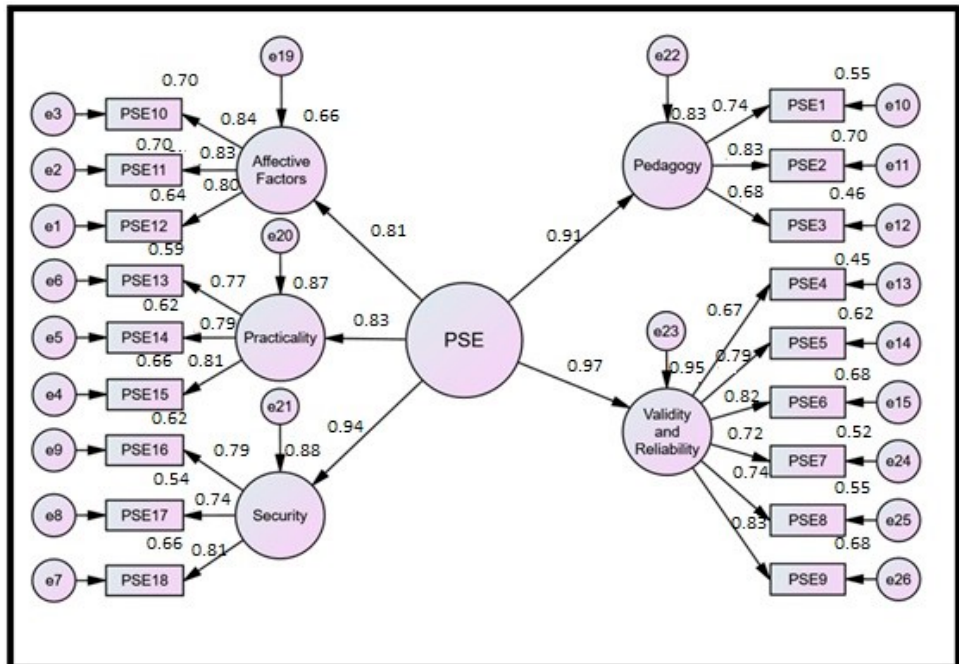
Figure 1. Perception of Students towards the Online Examination System.